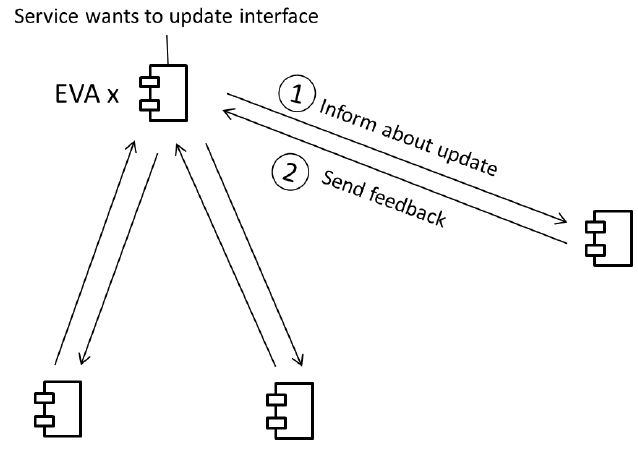
Figure 5. Coordination of EVAs based on client’s